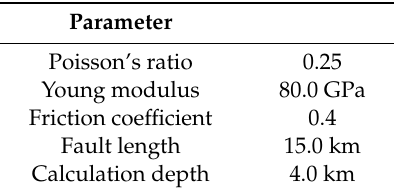
Table 5. Summary of the Coulomb 3.4 modelling parameters used in the computation for the 1989 earthquake (m bLg 5.2) displayed in Figure